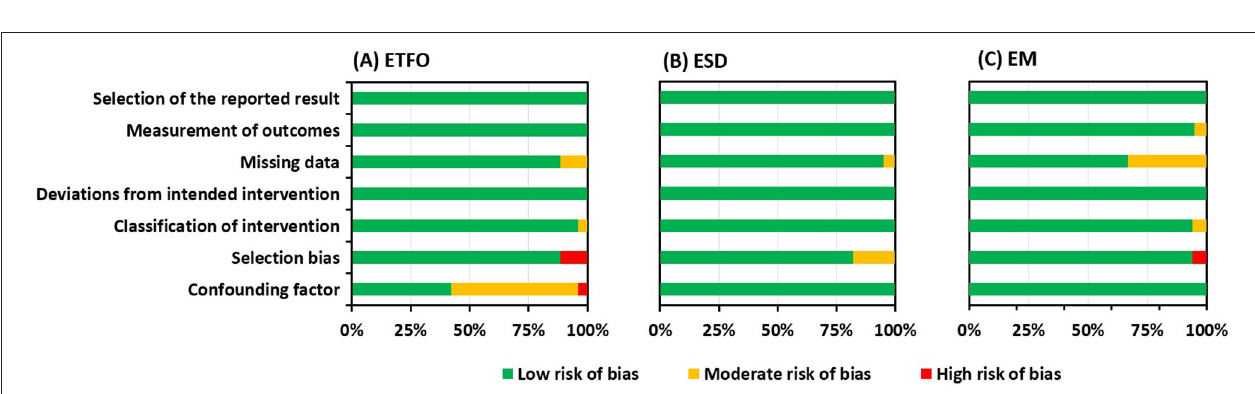
FIGURE 2 | Risk of bias graph: review authors’ judgment presented as percentages across all included studies about each risk of bias item for electrode tip fold over (ETFO) (A) , electrode scalar deviation (ESD) (B) , and electrode migration (EM) (C) .